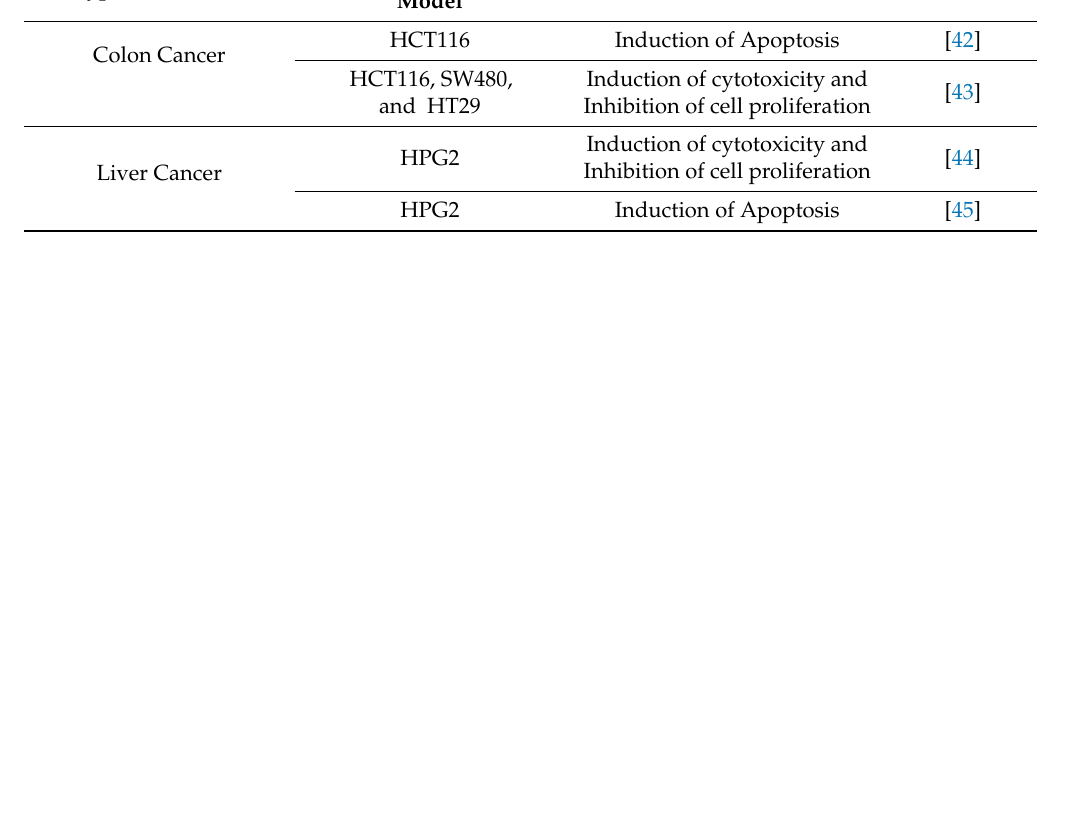
Table 2. E ff ects of sa ff ron on liver and colorectal cancer (CRC) cell lines and mechanisms of action. Types of